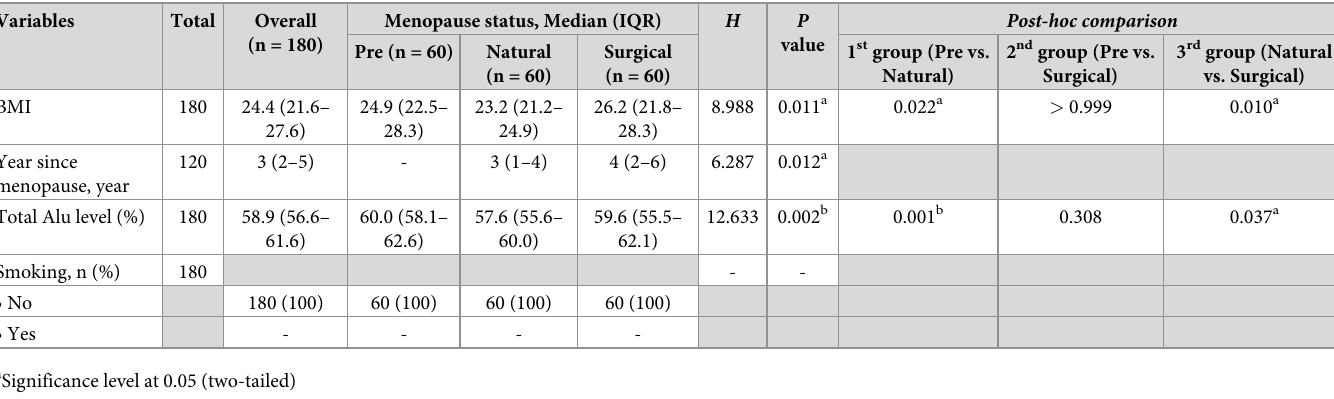
Table 1. Demographic data corresponding to the participants in each group and Post-hoc comparison.